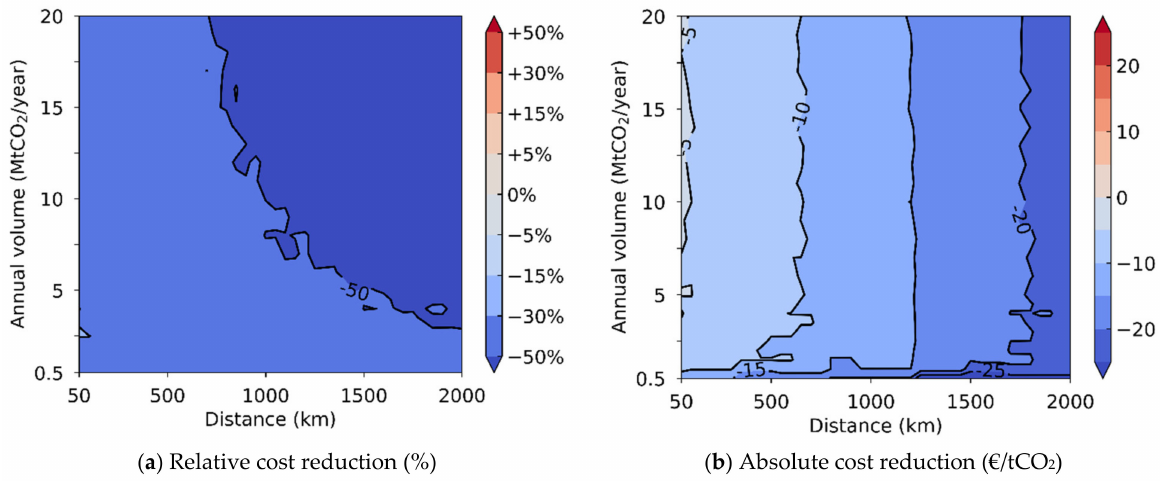
Figure 7. Cost comparison maps showing the cost reductions enabled by the 7 barg shipping option compared to the 15 barg one in the case of transport to an offshore site considering that the CO 2 entering the liquefaction process is at 90 barg